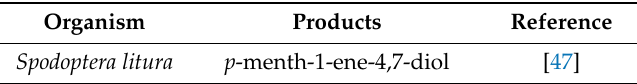
Table 4. Biotransformation of terpinen-4-ol.